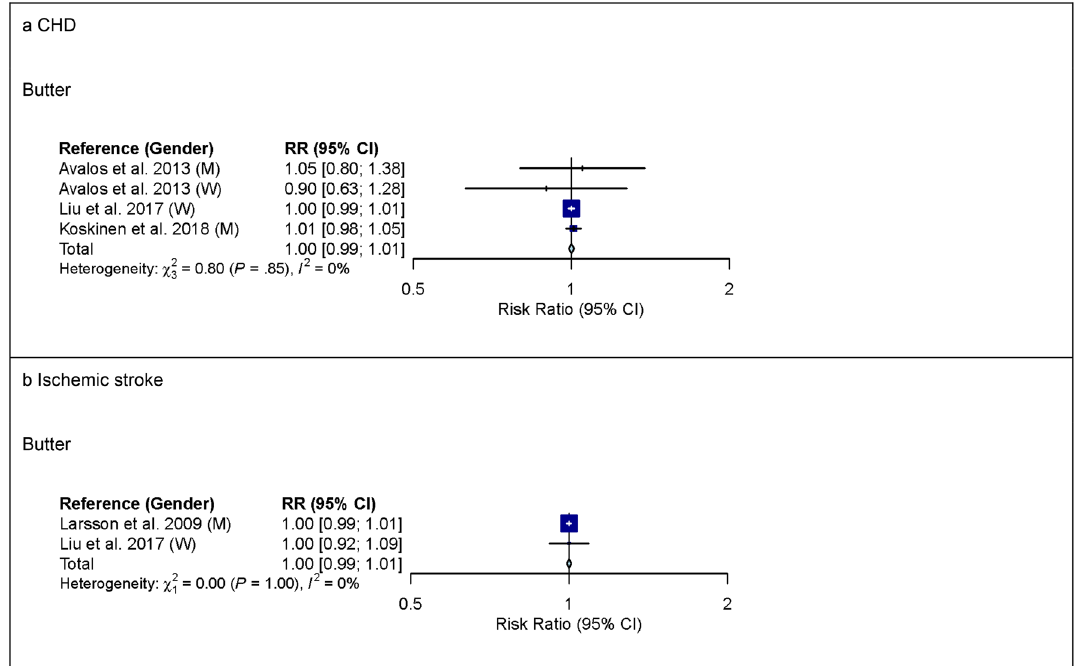
Figure 4. Linear dose–response meta-analysis. Summary RR of CHD (panel a ) and ischemic stroke (panel b ) per 6 g higher intake of butter/day. CHD coronary heart disease; CI confidence interval; M males; RR risk ratio; W